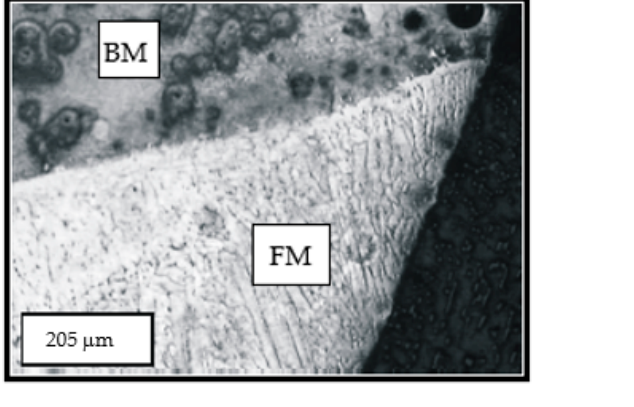
Figure 2. The two-layer hard-faced tooth top—the base metal (BM) and the filler metal (FM) ( a ); the transient line between the filler metal (FM) and heat-affected zone (HAZ) ( b ). The microstructure of the cemented layer hard-faced with the filler metal EVB2CrMo is shown in Figure 3. The basic micro-constituent in the hard-faced layer zone is the